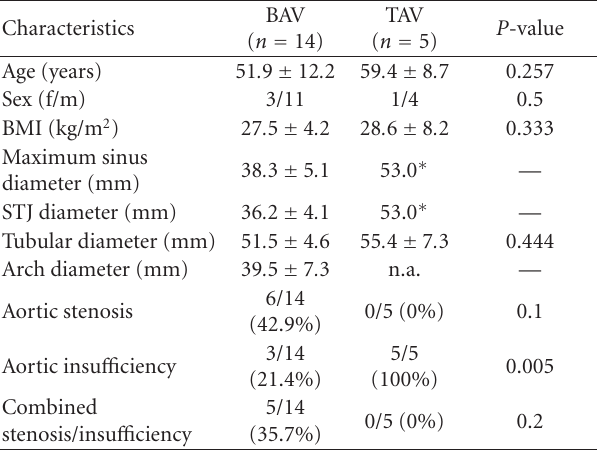
Table 1: Patient